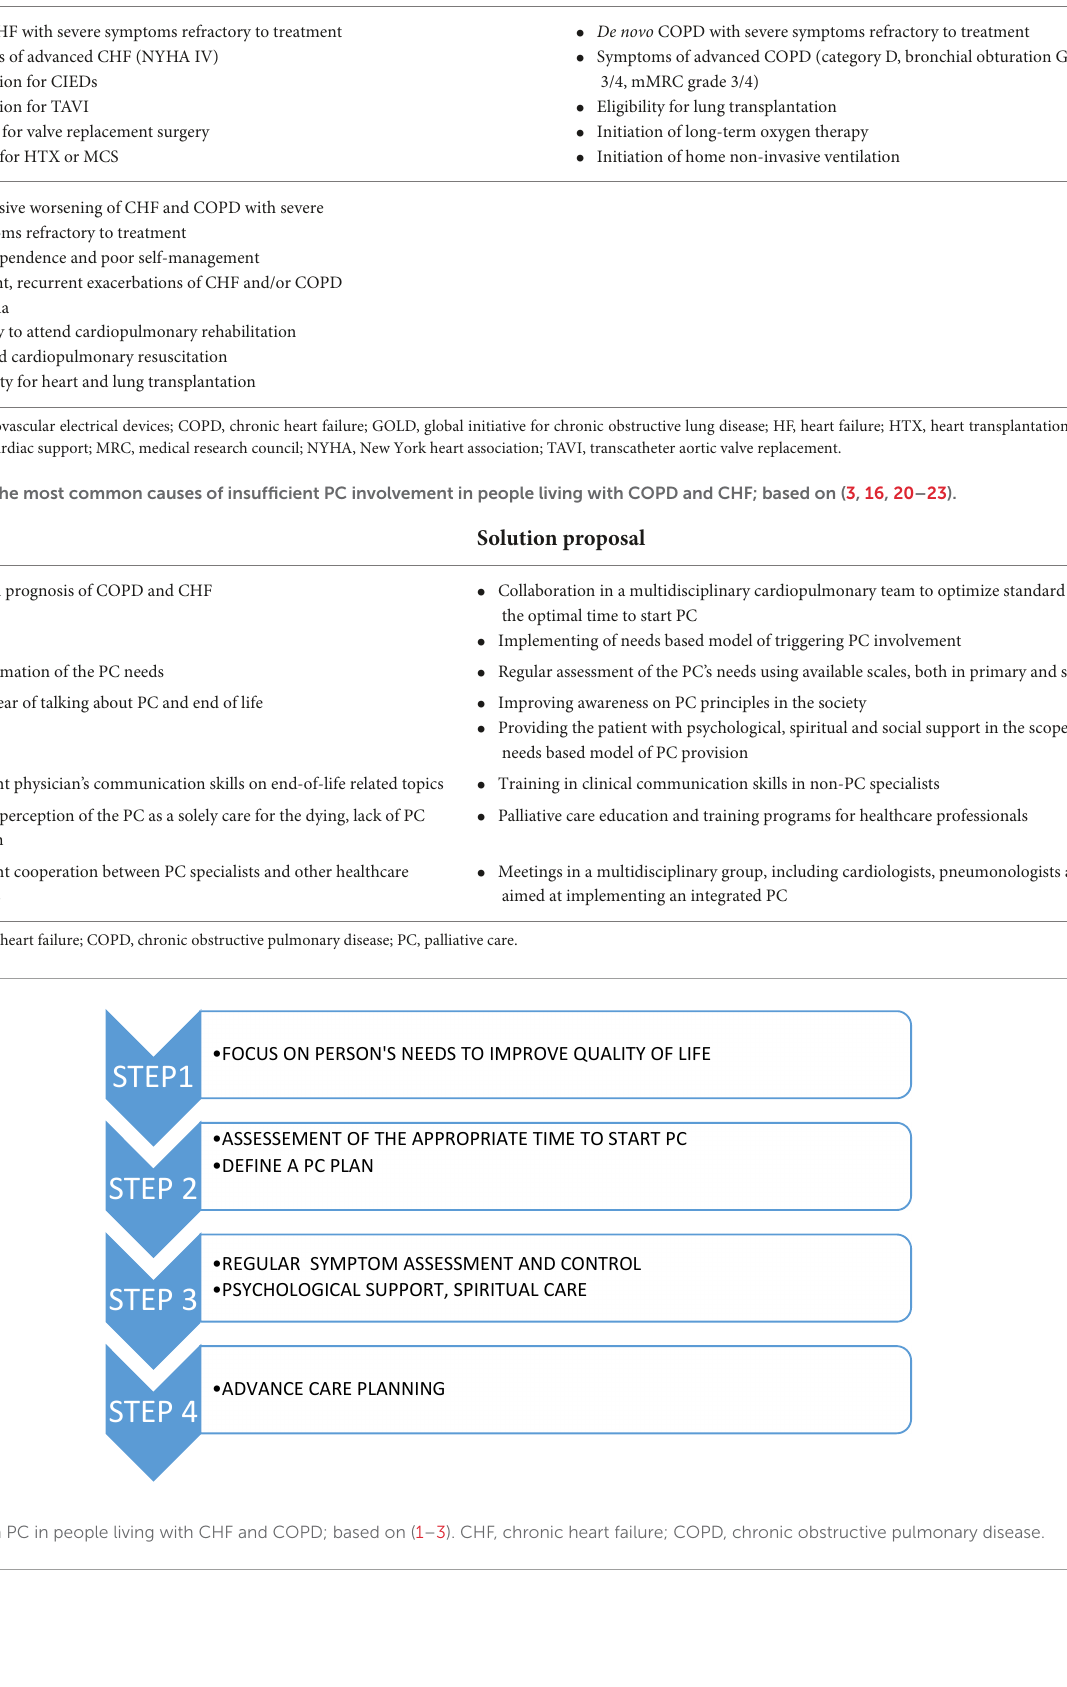
TABLE 1 The most important changes in the course of HF and COPD initiating the assessment of PC needs; based on: (1–3, 8, 11, 13, 132). HF COPD